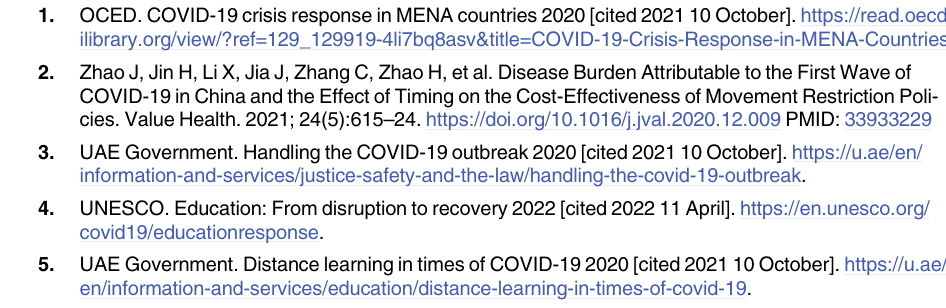
S1 Table. Perceptions towards online and hybrid learning (n =